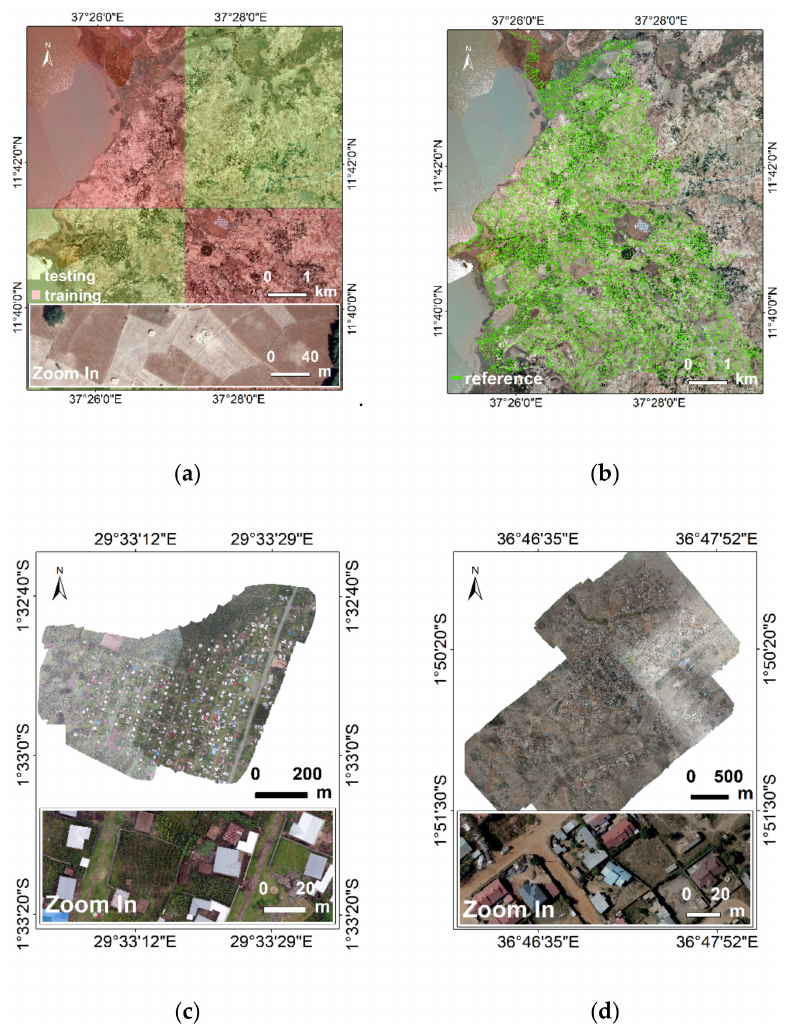
Figure 2. ( a ) Aerial image of 0.25 m Ground Sample Distance (GSD) for a rural scene in Ethiopia, divided into areas for training and testing our approach before comparing results to ( b ) the cadastral reference. Unmanned Aerial Vehicle (UAV) images for peri-urban scenes in ( c ) Rwanda (0.02 m GSD), and ( d ) Kenya (0.06 m GSD) to compare automated to manual